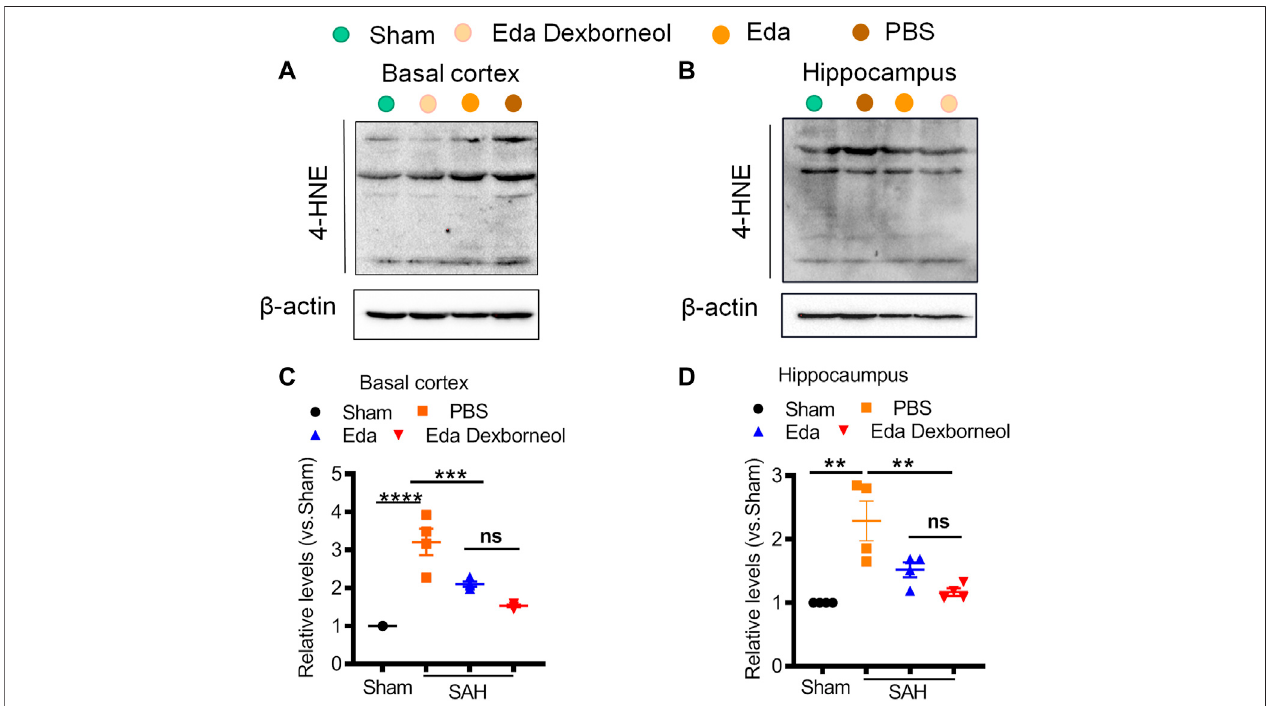
FIGURE 8 | Western blot showing that edaravone dexborneol treatment profoundly decreased the levels of 4-HNE in the brain after SAH injury. (A,B) Representative Western blot images show the expression of 4-HNE in the basal cortex (A) and CA1 hippocampus (B) tissue at 3 d after SAH. (C,D) Semiquantitative dataofWesternblotbandsfor4-HNEineachgroup.Dataarenormalizedtosham. n =4/group.* p < 0.05,*** p < 0.001,**** p < 0.0001.Eda:edaravone;Edadexborneol: edaravone dexborneol.